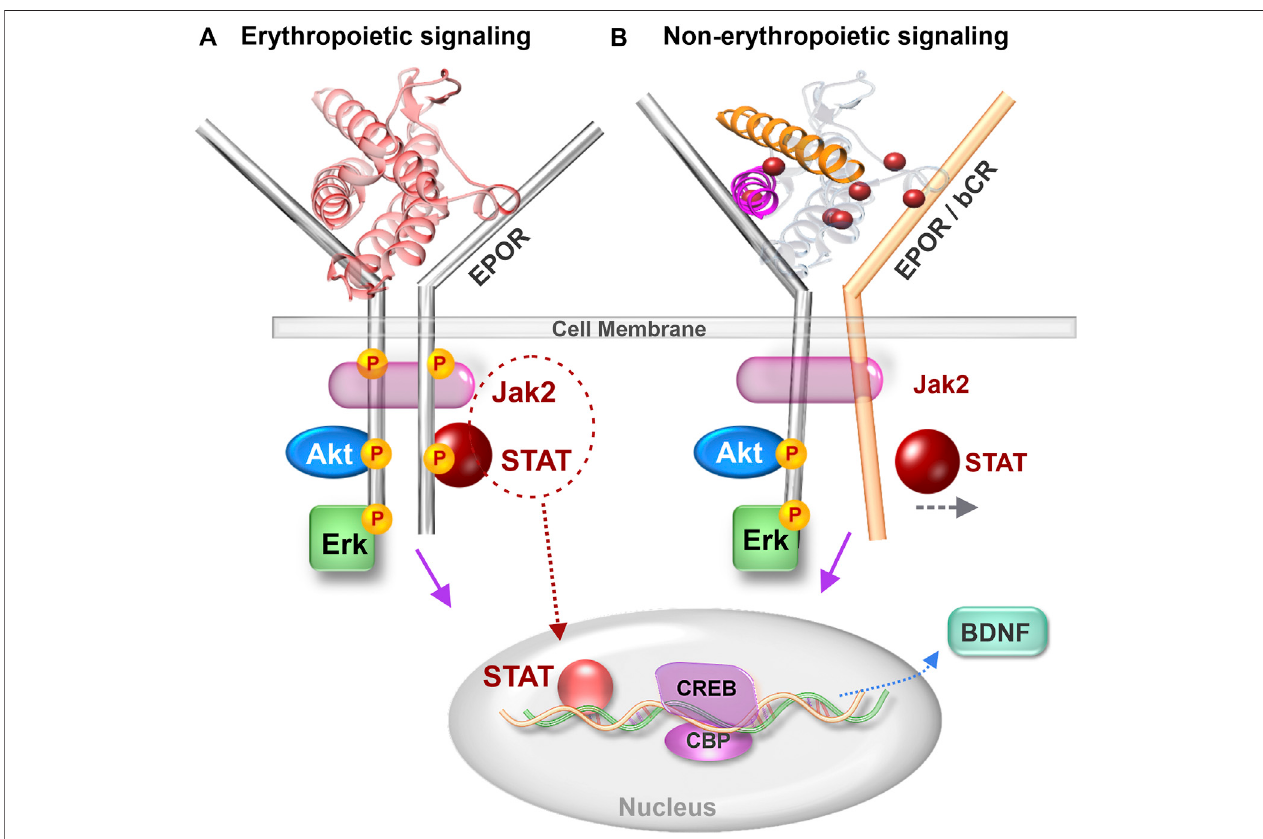
FIGURE 2 | Comparison of erythropoietic and non-erythropoietic receptor signaling. (A) Erythropoietic signaling induced by EPO binding to EPOR dimer and causing Jak2 driven phosphorylation of STAT. (B) Non-erythropoietic signaling induced by binding of non-erythropoietic EPO-mimetic molecules such as CEPO, ARA 290 and NL 100. Non-erythropoietic molecules bind to either an EPOR-bCR heteroreceptor or cause the EPOR dimers to depart from the 120 ° angular orientation that supports erythropoiesis. Jak 2 – Janus kinase 2, STAT - Signal transducer and activator of transcription, EPOR – erythropoietin receptor, bCR – betacommon receptor, CREB – cAMP response element binding protein, CBP – CREB binding protein and BDNF – Brain derived neurotrophic